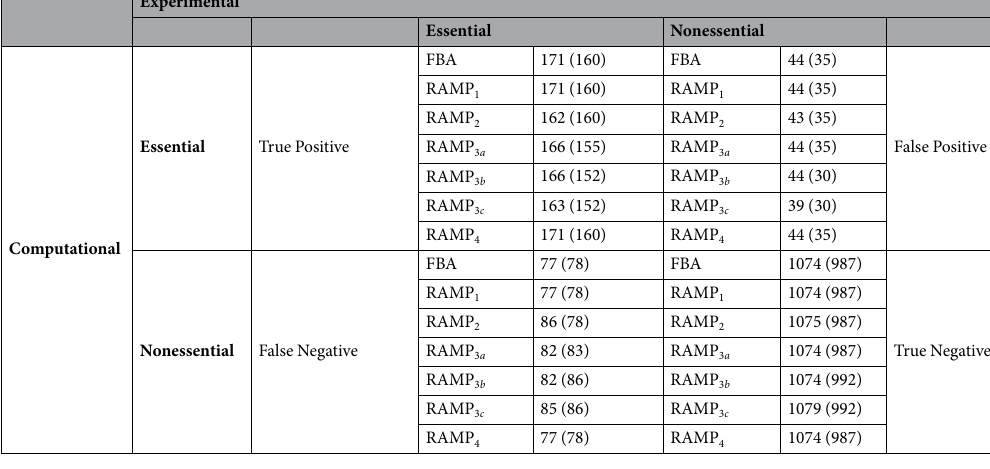
Table 3. Predictability of gene knockouts using stochastic models 1, 2, 3, and 4 for RAMP compared with FBA. RAMP models 3a, 3b, and 3c have increasing levels of stochastic variation, respectively. Results for the iAF1260 metabolic model are in parentheses, all other results are for the iJO1366